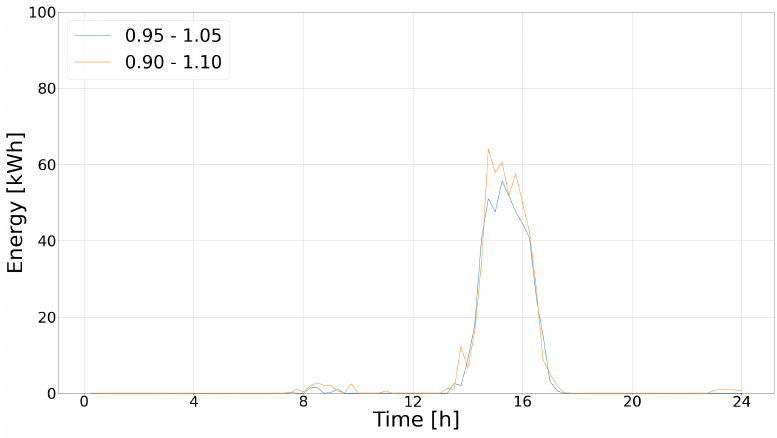
Figure 9. Average M R value over all scenarios for all time